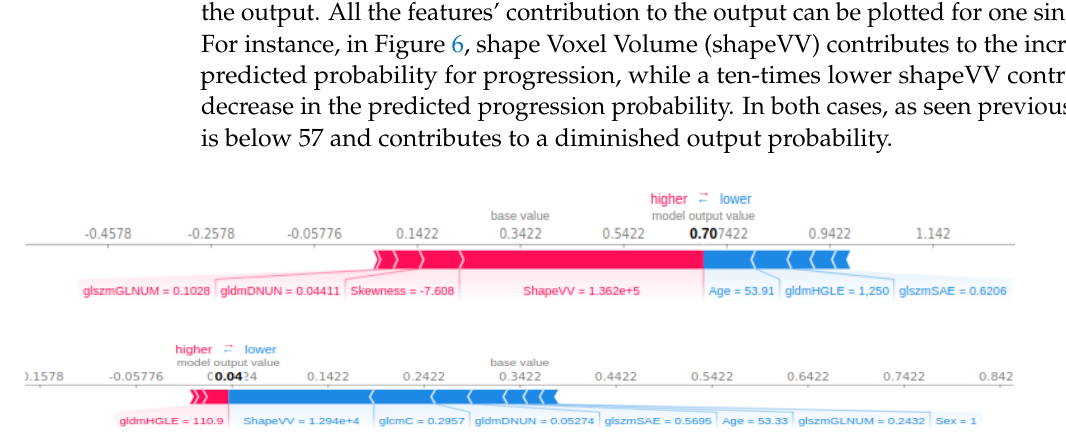
Figure 6. Contributions of features for a patient predicted as progression (higher) and a patient predicted without prediction (lower). gldmDNUN: gldm Dependence Non-Uniformity Normalized; gldmDLGLE: gldm Large Dependence Low Grey Level Emphasis; glcmC: glcm Correlation; glszmGLNUN: glszm Grey Level Non-Uniformity Normalized; glszmSAE: glszm Small Area Emphasis.